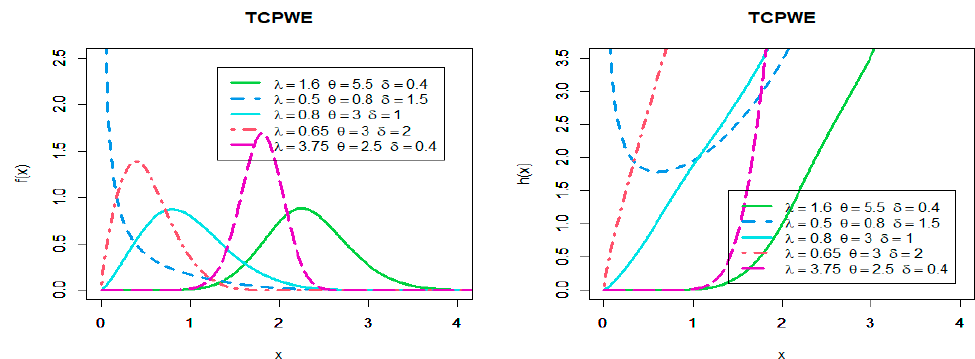
Figure 2. Plots of PDF and the hazard function of TCPWE distribution.